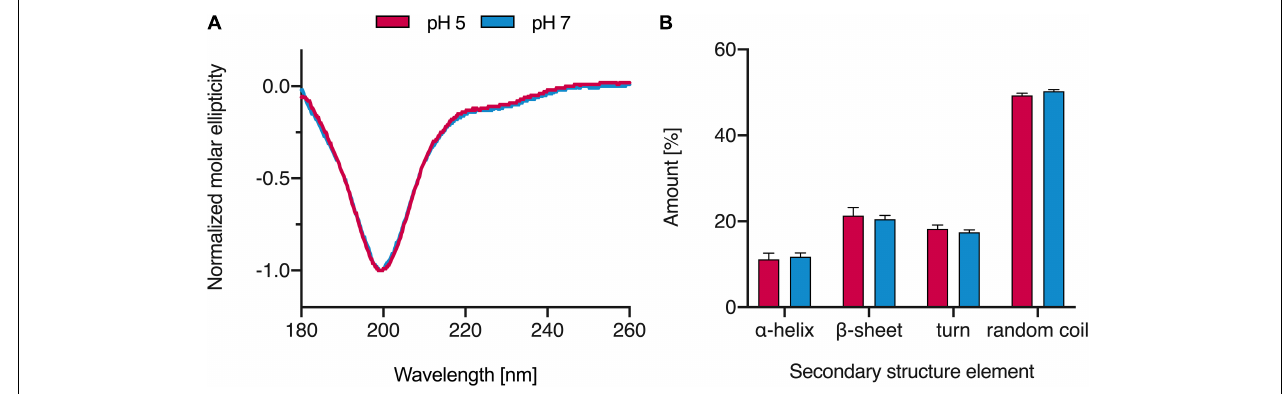
FIGURE 5 | CD spectra of HBB(112–147). (A) The peptide was dissolved in MilliQ water at pH 5 and 7 and CD spectra were recorded. (B) Secondary structure elements of HBB(112–147) based on the analysis of CD spectra results; spectra were baseline corrected against MilliQ water, smoothened and normalized. Values shown were derived from triplicate measurements ( + SD).